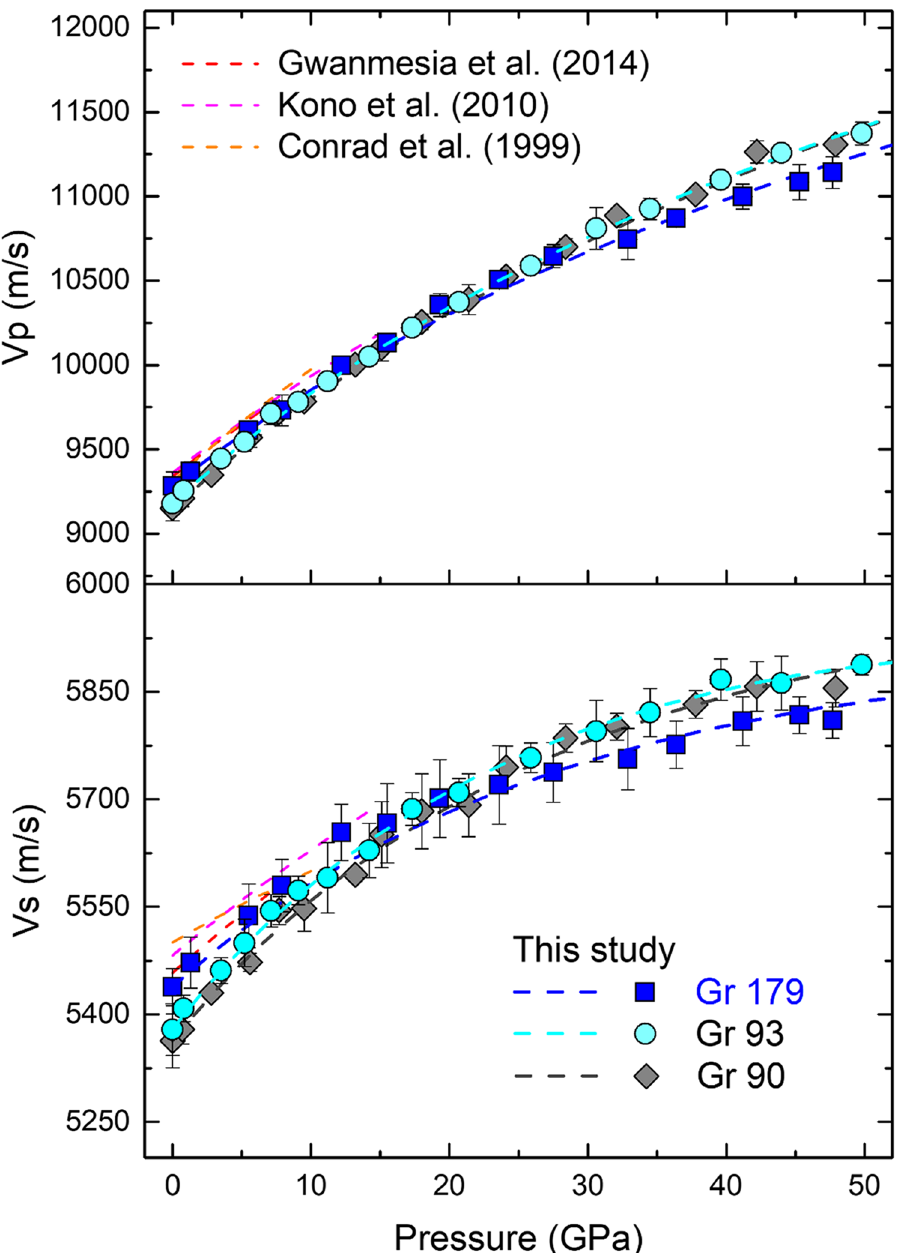
Figure 3. Sound velocities of ultrafine micro/nanocrystalline grossular up to 50 GPa. Previous studies are plotted with dashed lines in red, magenta and orange